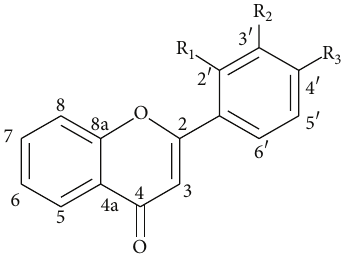
Figure 1: Structure of flavone derivatives.